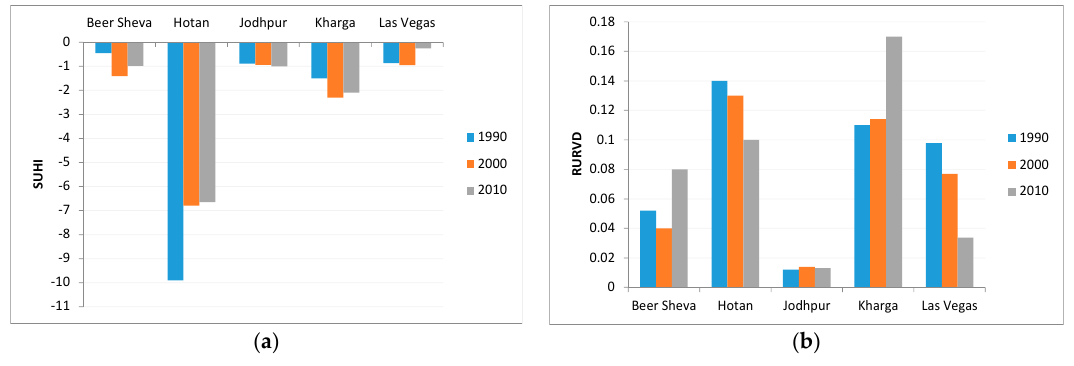
Figure 6. Urban-rural difference in ( a ) LST (=SUHI) and ( b ) NDVI (=RURVD) for the five cities.